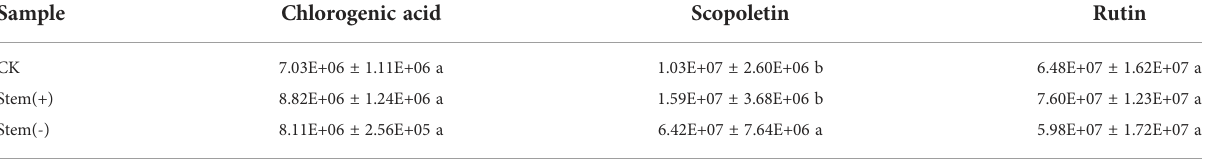
TABLE 1 Polyphenols contents in fl ue-cured tobacco